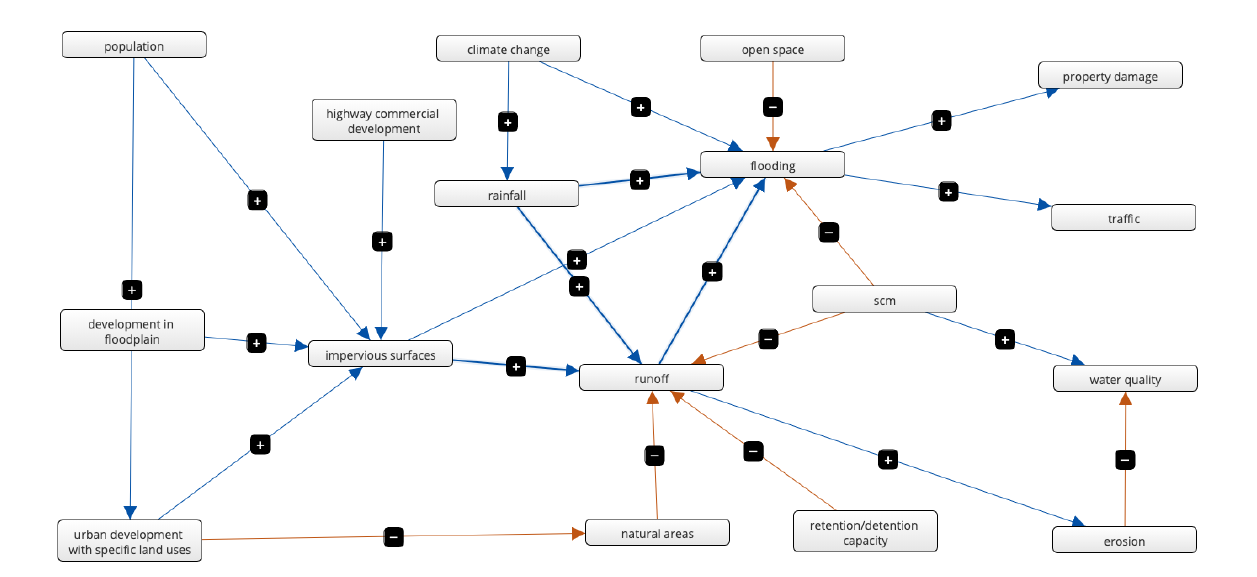
Figure 6. The regional FCM shown is filtered to exclude weak causal connections and reveal the core model structure. The model shows that stakeholders perceive population and climate change as two driving forces contributing to increased impervious surface and rainfall. Stakeholders also included causal relationships for management strategies, such as decreasing development in the floodplain to reduce impervious surfaces, adding additional retention/detention capacity, and other stormwater control measures to reduce runoff and flooding.